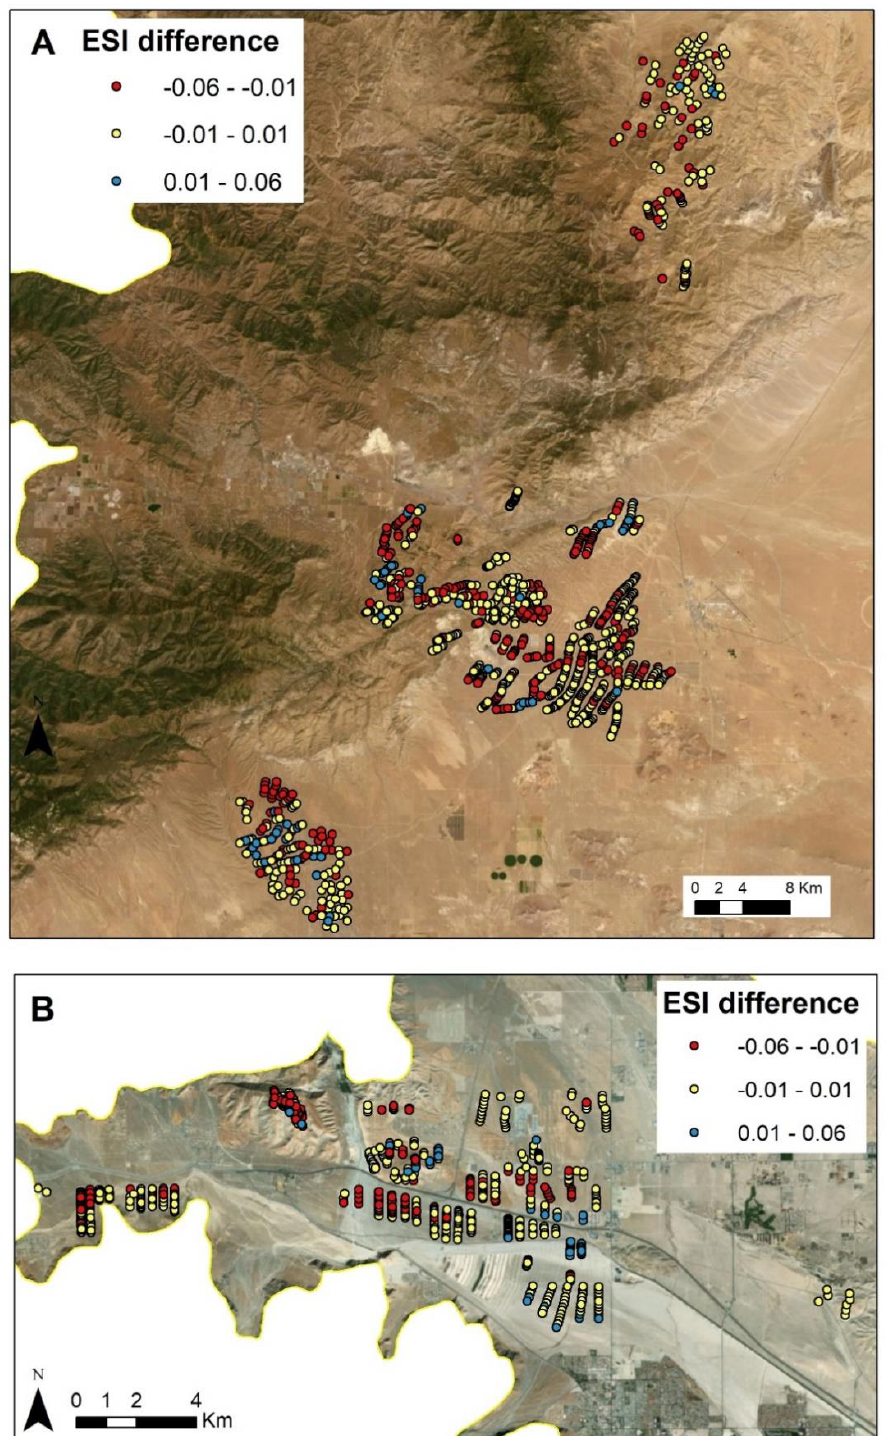
Figure 6. Di ff erence in Early Season Invasives (ESI) index values before and after turbine construction compared to control areas at ( A ) Tehachapi and ( B ) Desert Hot Springs Desert. Data are classified into quantiles, where negative values (red) show areas where the post-installation minus pre-installation ESI changes measured at turbines was greater than at the control sites, and positive values (blue) are where the ESI changes measured at control sites was greater than at the turbines. Yellow values show where ESI changes at turbine and control were similar.